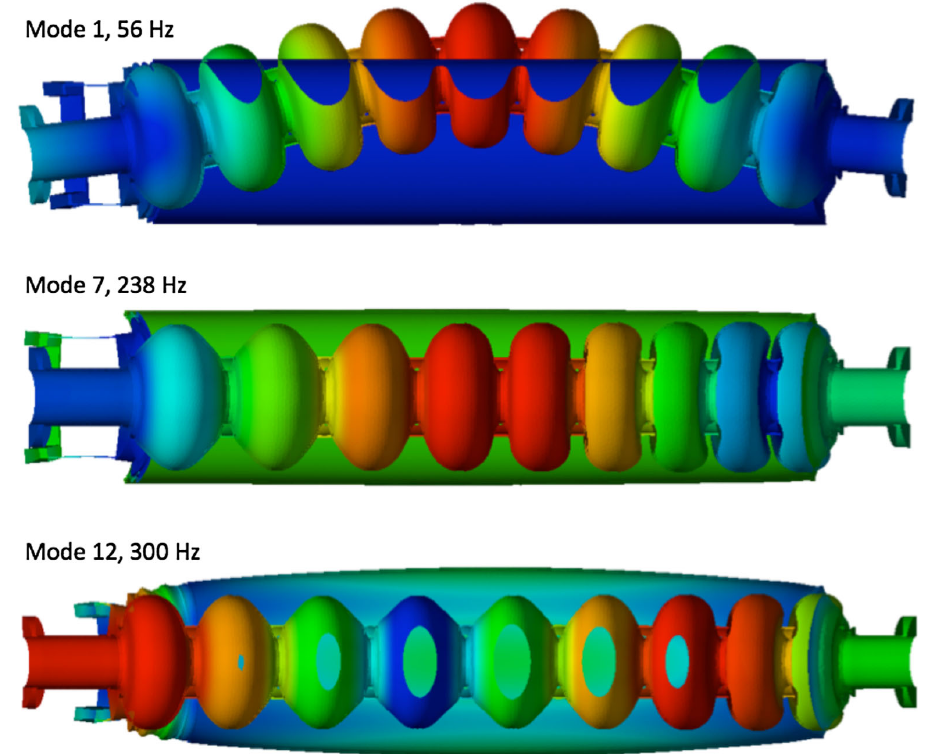
FIG. 7. Illustrations of the structural displacements for three selected modes. The magnitudes of the displacements (a.u.) are color coded on a linear